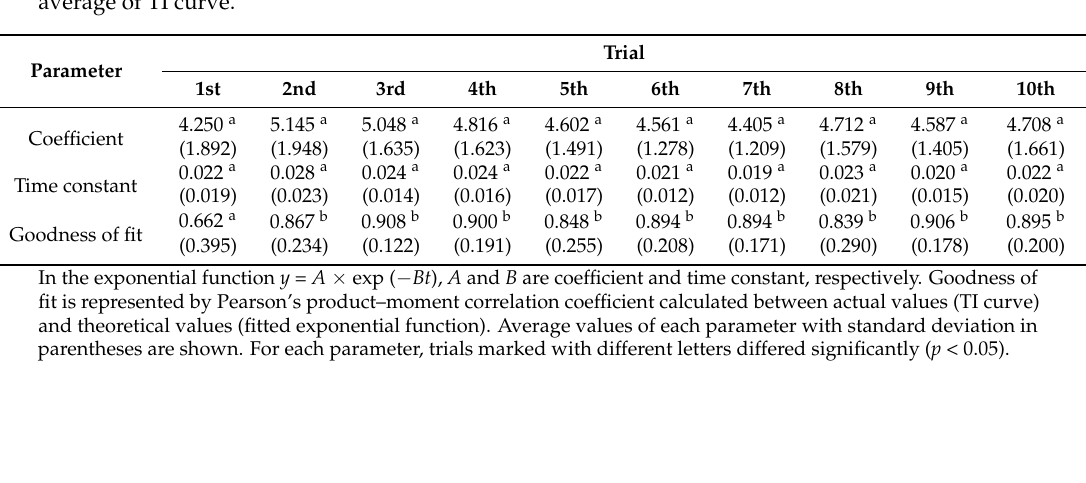
Table 3. Coefficient, time constant, and correlation coefficient of fitted functions for inter-participant average of TI